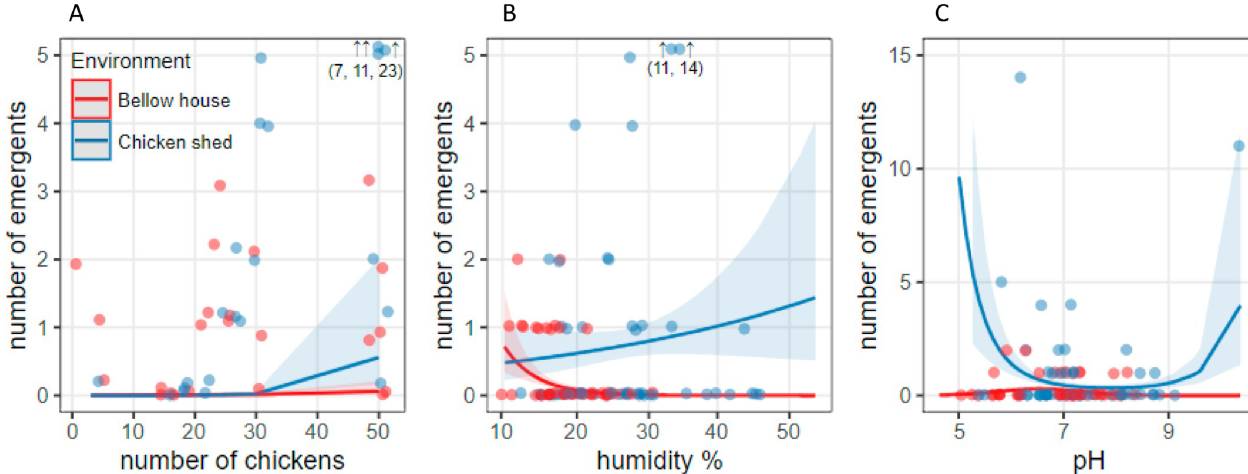
Fig 4. Trap success in each environment (number of newly emerged phlebotomines /the number of trap-nights) in each environment (below house and chicken shed) as a function of (A) number of chickens present on the farm, (B) soil humidity percentage (C) soil pH values. Dots: abundance of newly emerged phlebotomines. Lines: values predicted by the corresponding models (see Table 4). Shaded areas are confidence intervals. Abundances observed outside the ranges are indicated with their value and an arrow. Note that some observations indicated with arrows were relocated (observed values are reported in